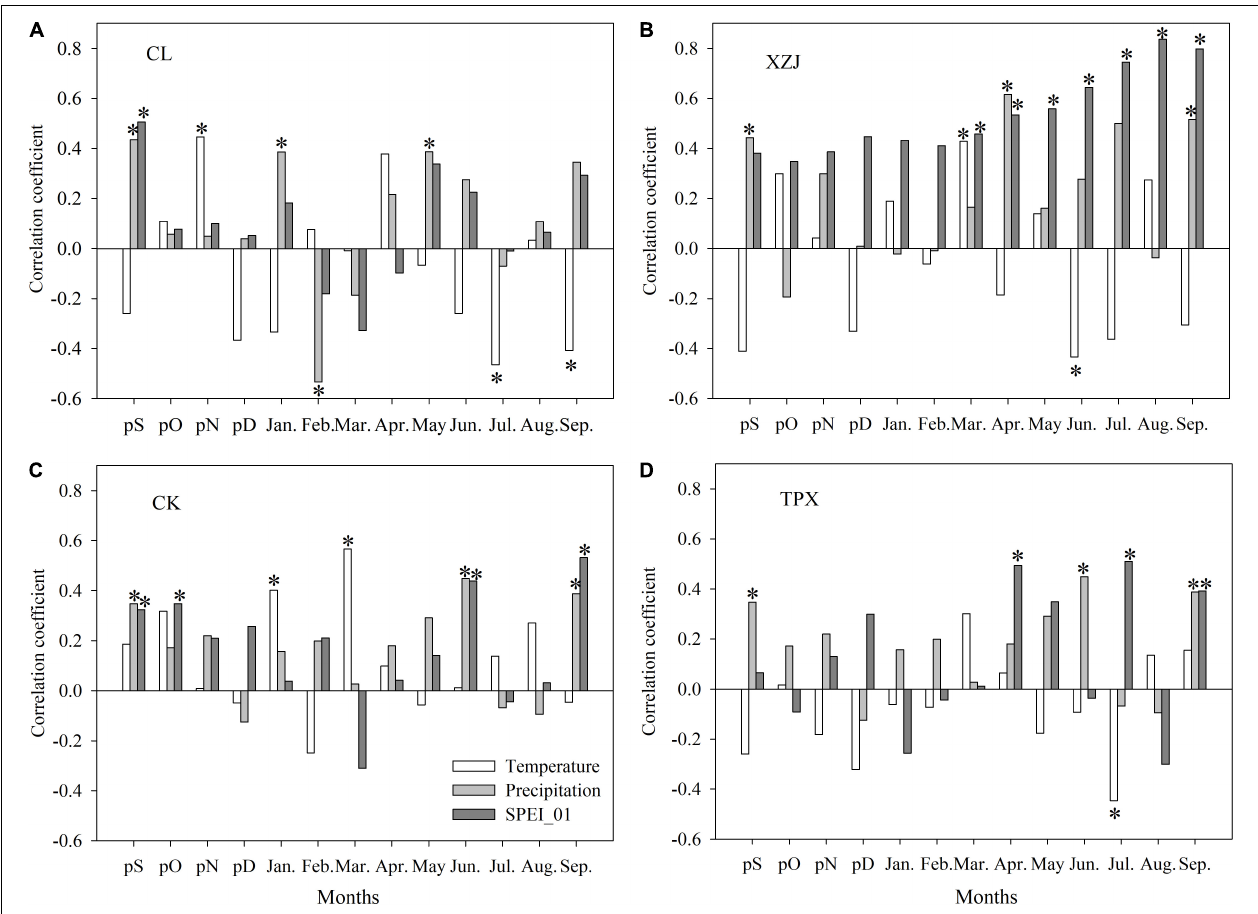
FIGURE 5 | Correlation coefficient between ring-width chronologies and month mean temperature, month total precipitation and SPEI_01 from September of the previous year to September of the current year (Significance: * p < 0.05). (A) CL, (B) XZJ, (C) CK, and (D) TPX.